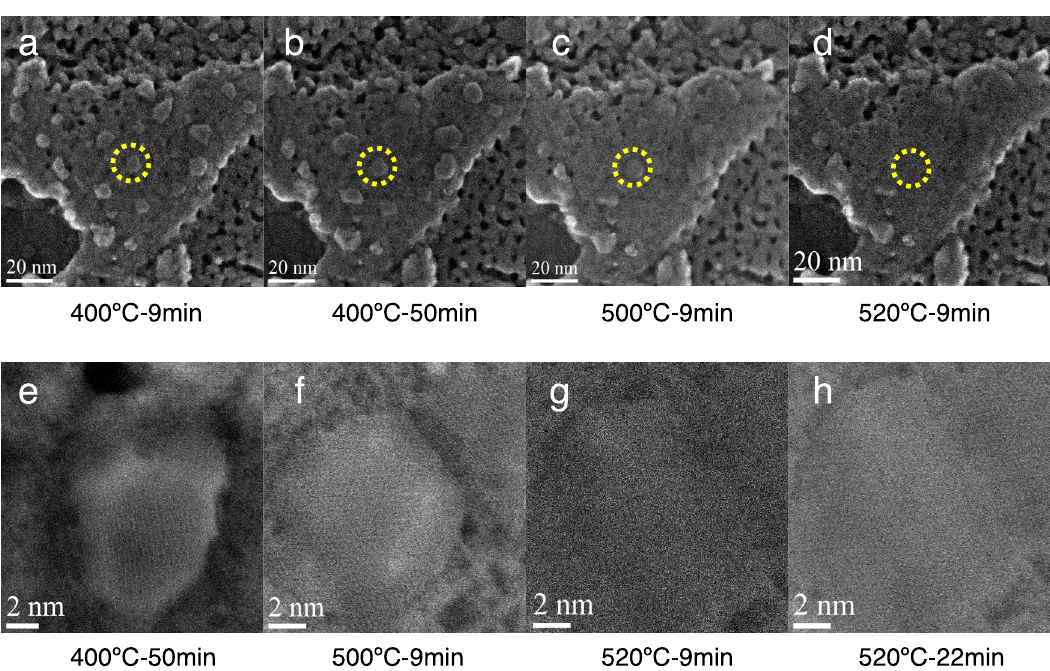
Fig. 5 Environmental SE/STEM characterization. The evolution of Ni particles on the support of γ -Mo 2 N in the fl ow of H 2 /N 2 at a ratio of 3:1 under different pretreatment temperature, a – d large scale SE/STEM images of the Ni-4nm/ γ -Mo 2 N catalyst at 400°C for 9 min, 400 °C for 50 min, 500 °C for 9 min and 520 °C for 9 min, e – g high resolution images of selected region (marked as yellow circle in b – d , h high resolution images of Ni-4nm/ γ -Mo 2 N catalyst at 520 °C for 22